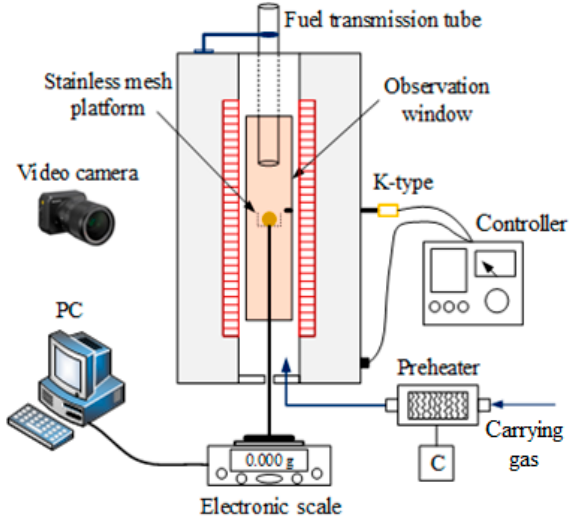
Figure 2. Single-pellet combustion system.